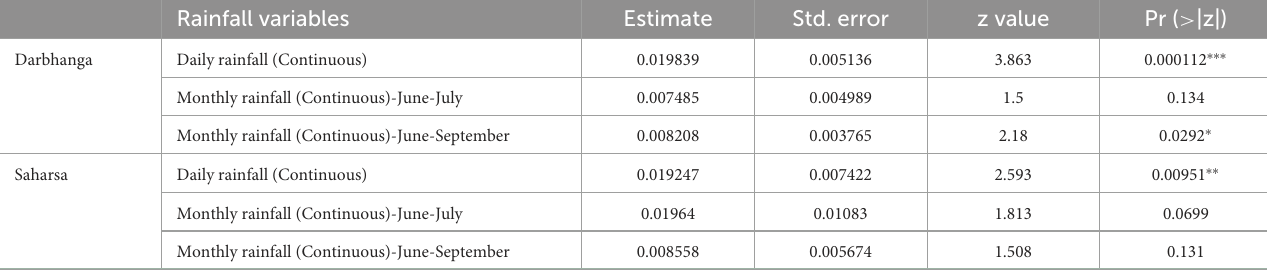
TABLE 2 GLM_ flood vs. rainfall between 1991 and 2015 for Darbhanga and Saharsa. Rainfall variables Estimate Std.